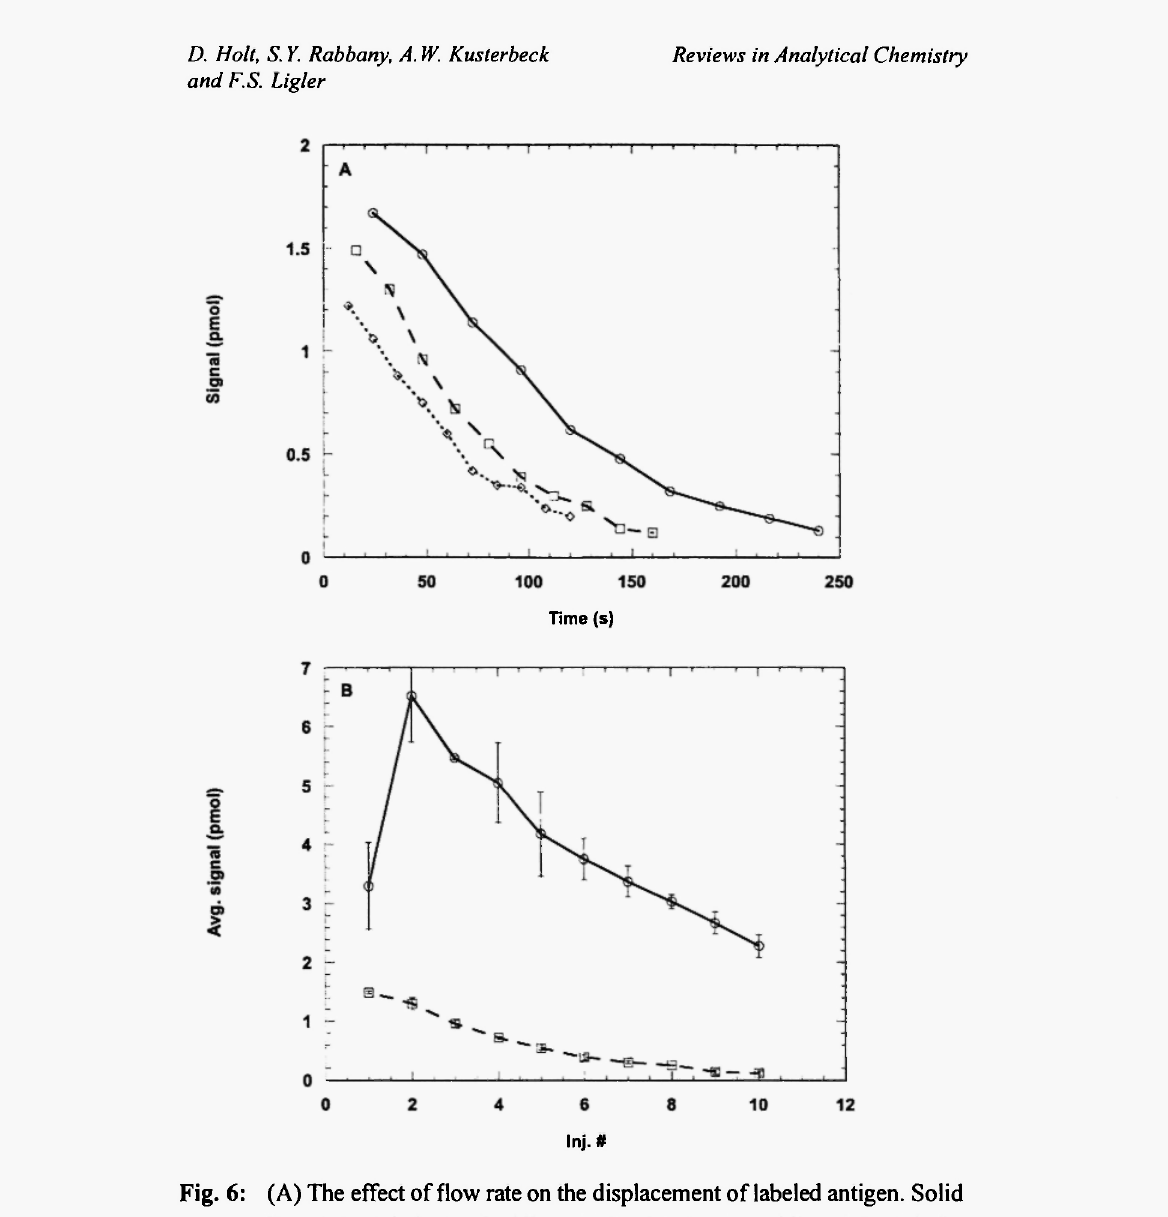
Fig. 6: (A) The effect of flow rate on the displacement of labeled antigen. Solid line: 0.5 mL/min. Dashed line: 0.75 mL/min. Dotted line: 1.0 mL/min. The data represent the mean of two experiments. The displacement efficiency decreases with increasing flow rates, but the displacement rate increases with the flow rate. (B) Labeled antigen displacement from high density (solid line, 245 pmol of immobilized antibody) and low (broken line, 50 pmol of immobilized antibody) density matrices. Samples of cocaine were injected repeatedly at a flow rate of 0.75 mL/min. The data represent the mean ±S.E. of two